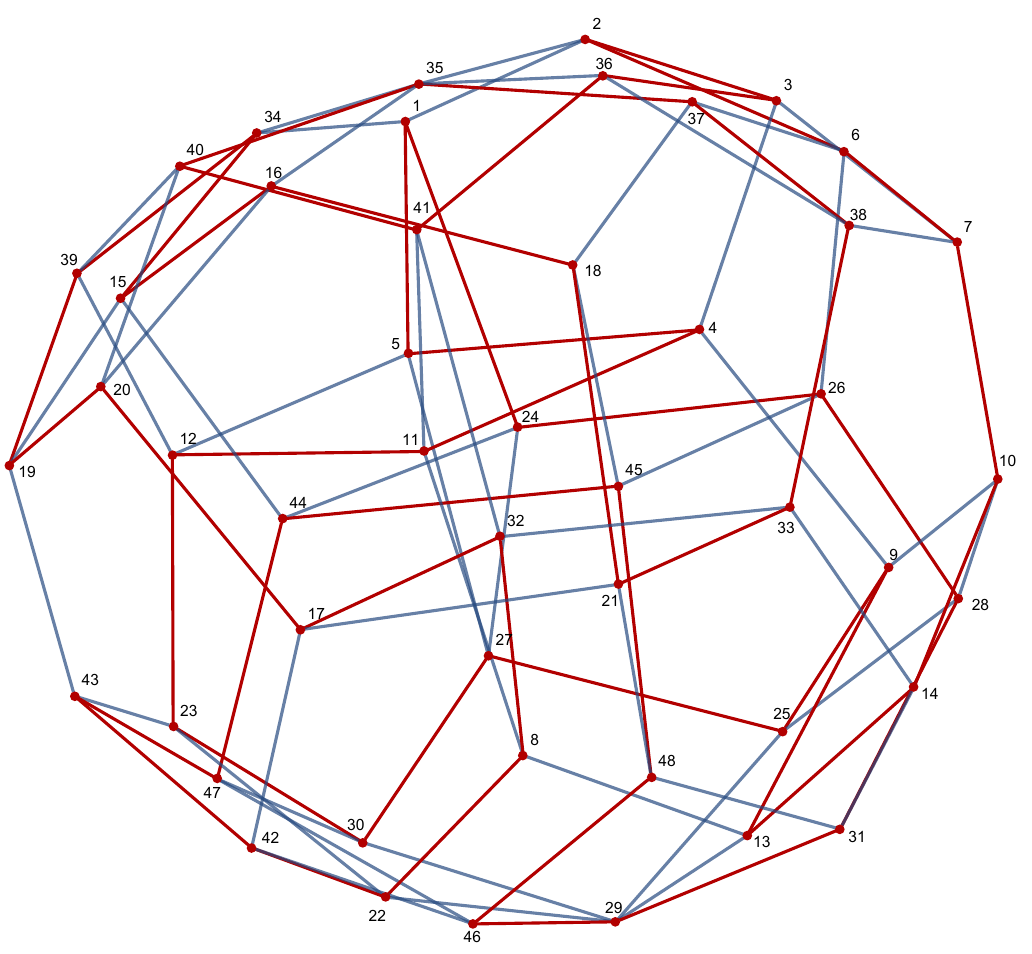
Figure 9 . Each vertex represents a planar collection. The degree of a vertex is the number of degenerations. There are 46 vertices of degree 4 and 2 vertices, i.e. v 29 and v 35 , of degree six. The Hamiltonian cycle used in this work is highlighted in